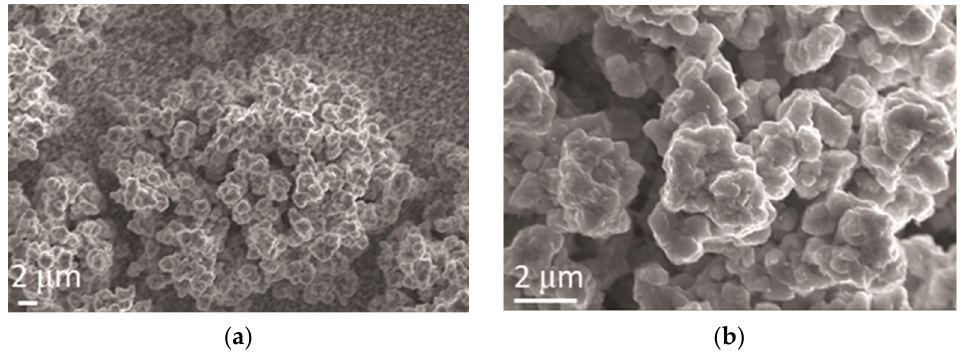
Figure 5. Morphology of Zn-Co alloy obtained by electrodeposition at a current density of 2 A dm − 2 . Magnification: ( a ) × 5000 and ( b ) ×